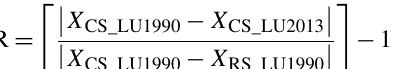
Table 2. Combined land use scenarios, soil parameterizations and time scales